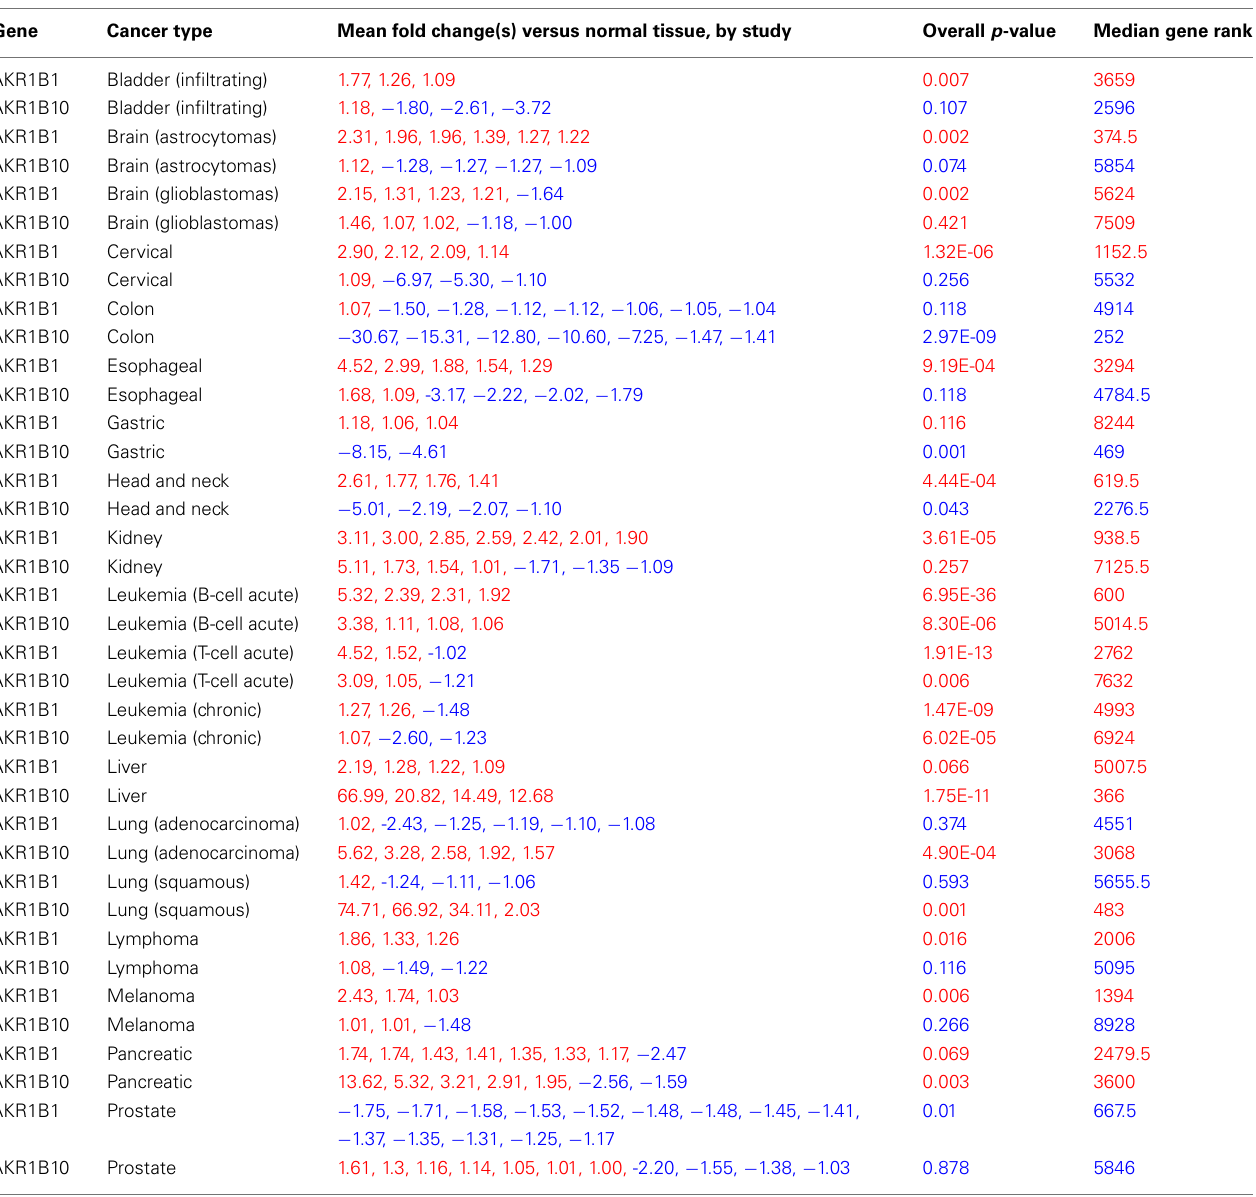
Table 1 |AKR expression in human